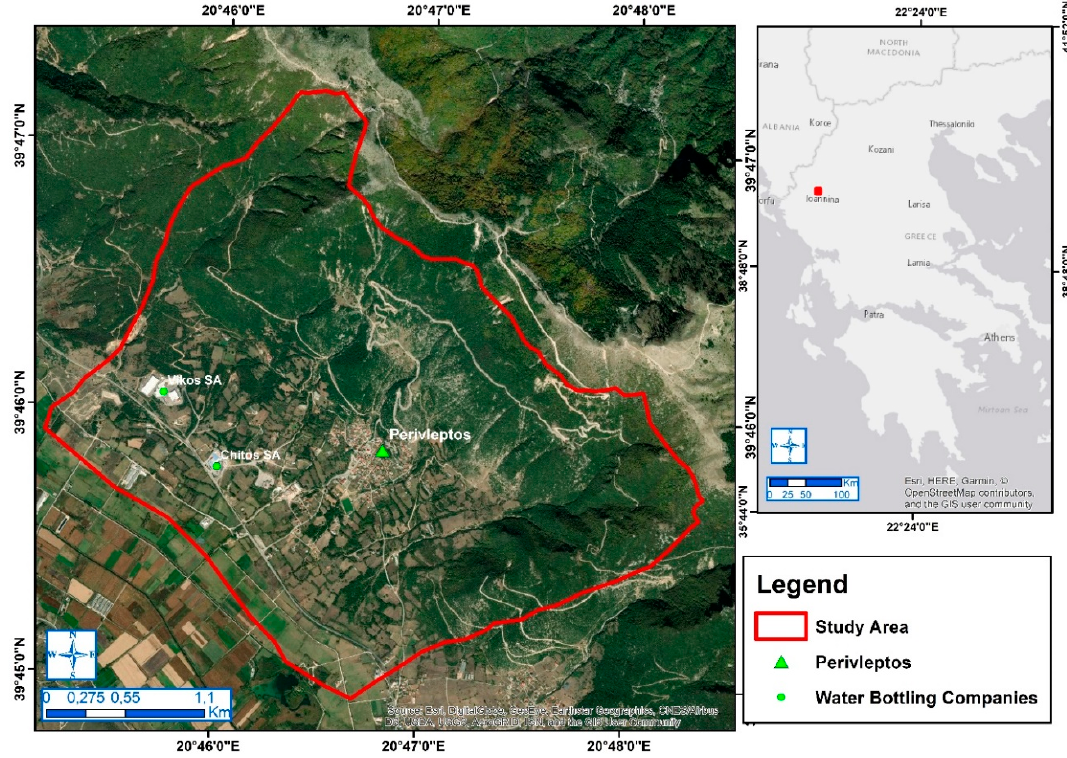
Figure 1. Test Site Perivleptos, NW Greece.